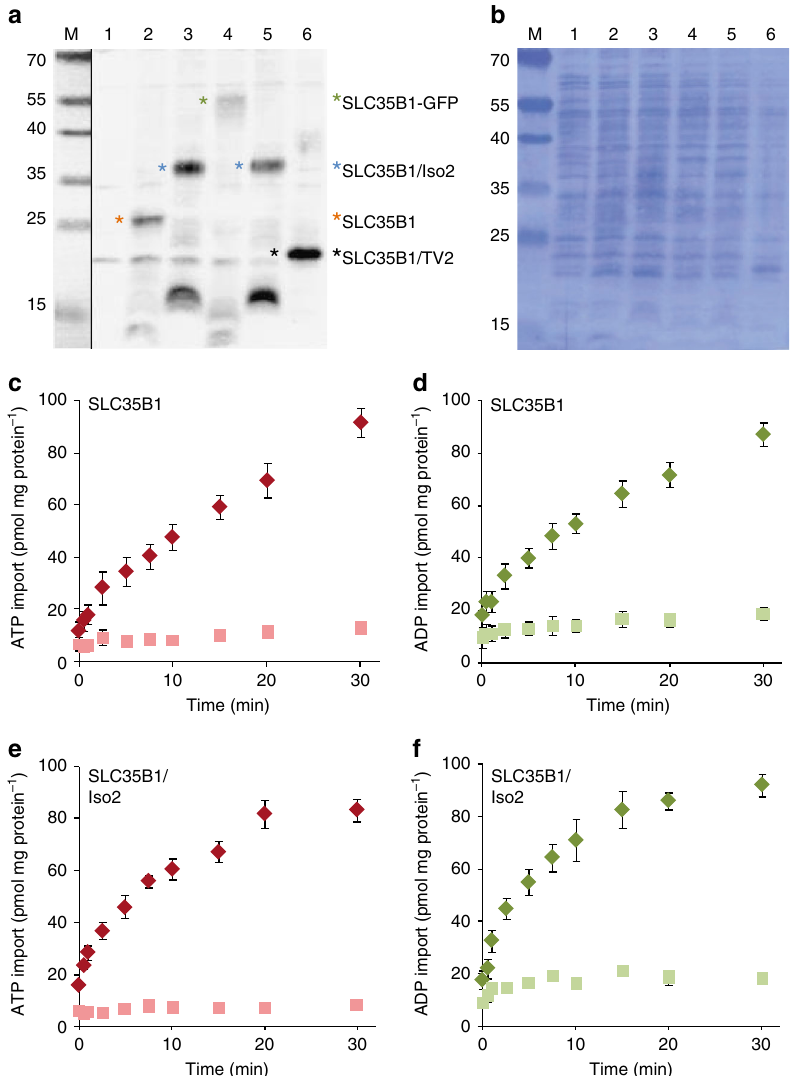
Fig. 2 Heterologously expressed SLC35B1 and SLC35B1/Isoform 2 are ATP and ADP carriers. The indicated SLC35B1 variants (labeled by asterisk in a , which were described in the legend to Fig. 1a, plus a phosphomimetic variant of Isoform 2 with aspartate residues at positions 15 and 29 instead of serines (termed Isoform 2DD, lane 5), and the GFP-tagged version of SLC35B1 were expressed in different E. coli cells. a , b Membranes were isolated from the indicated E. coli cells, and samples (25 µ g protein) analyzed by SDS-PAGE and Western blotting using an SLC35B1-speci fi c antibody, which was characterized in Supplementary Fig. 1a ( a ). Non-induced cells served as a negative control and are shown in lane 1. Coomassie staining the blot for total protein served as a loading control ( b ). A molecular mass standard (M) was run in parallel and electronically copied from the stained blot to the Western blot image. c – f Uptake of 50 µ M [ α 32 P]ATP ( c – e ) or [ α 32 P]ADP ( d – f ) into SLC35B1-expressing ( c , d ) or SLC35B1/Isoform 2-expressing cells ( e , f ) was measured and compared to uptake by non-induced cells. Data are reported as the mean of at least three independent experiments and are shown with the standard error of the mean (SEM). Related substrate saturation experiments and corresponding Eadie-Hofstee analyses revealed apparent K M values for ATP and ADP plus maximal uptake rates and are shown in Supplementary Fig.